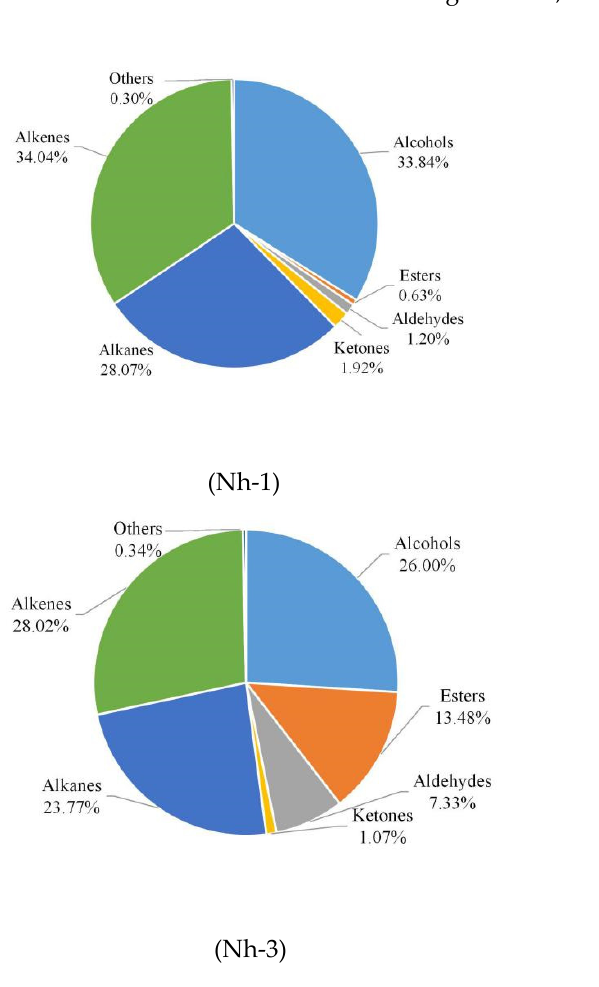
Figure 5. Percentages of alcohols, esters, aldehydes, ketones, alkanes, alkenes, and other volatile compounds released from fully open flower petals of N. hybrid . Table 3. Linear correlation coefficients among different classes of volatile